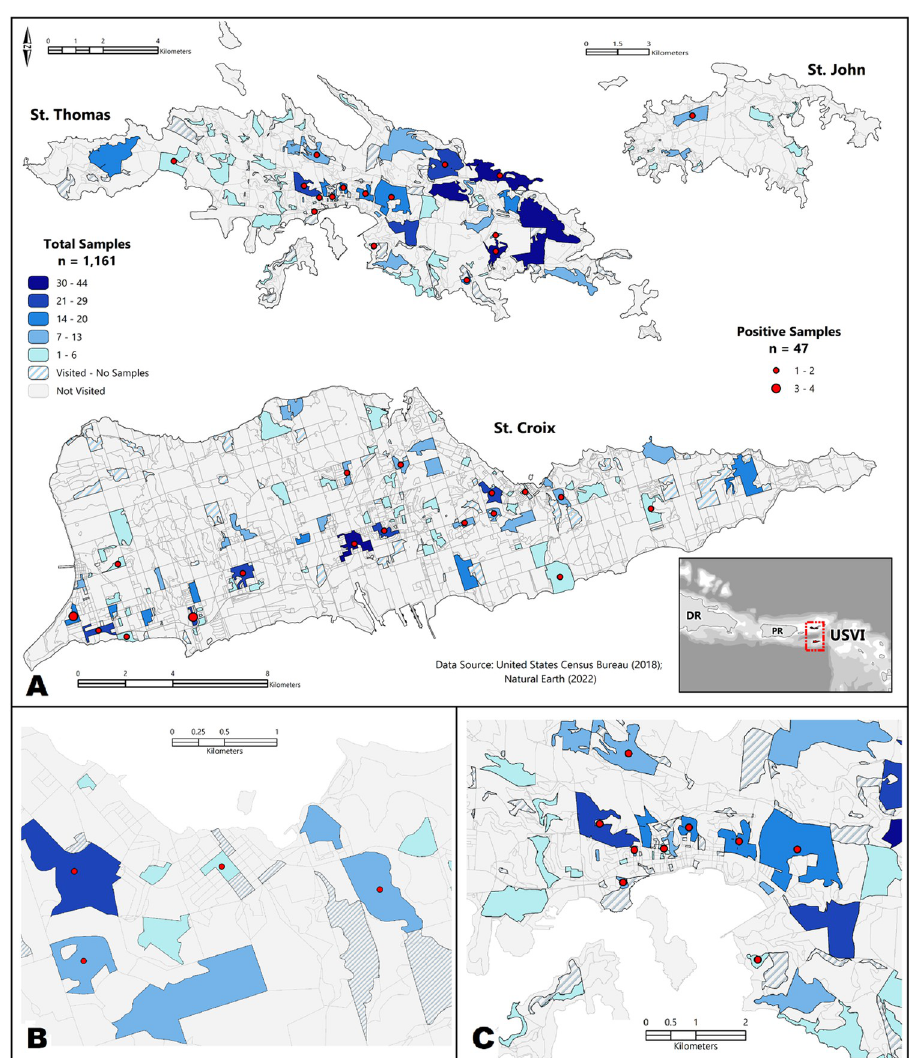
Fig 2. Distribution of collected samples and seropositive results by census block in the USVI leptospirosis serosurvey, March 2019. Panel A) Three main islands of USVI; Panel B) Magnification of Christiansted, St. Croix; Panel C) Magnification of Charlotte Amalie, St. Thomas. Sources: United States Census Bureau (FIPS Code: 78, https://www2.census.gov/geo/tiger/TIGER2018/TABBLOCK/); Natural Earth Data–country boundaries (https://www. naturalearthdata.com/downloads/10m-cultural-vectors/), bathymetry (https://www.naturalearthdata.com/downloads/ 10m-physical-vectors/). Characteristics significantly associated with seropositivity by bivariate analysis included residing in an urban neighborhood (pRR: 3.0; 95% CI: 1.0–9.0, p = 0.03), fishing as an occupa- tion (pRR: 9.2; 95% CI: 2.3–36.6; p < 0.001), seeing rodents or evidence of rodents in or around the house or land (pRR: 2.6; 95% CI: 1.2–6.0; p = 0.01), seeing deer in or around the house or